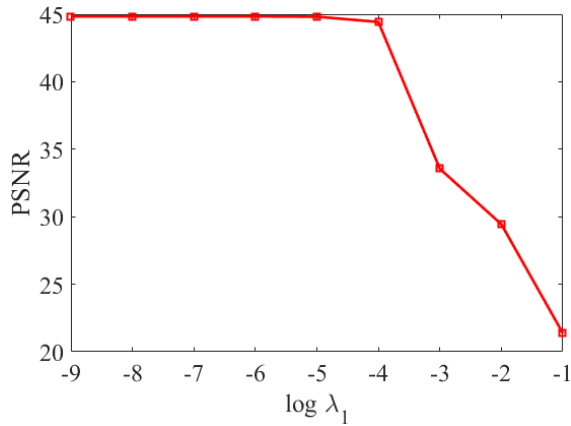
Figure 3. PSNR values for different log λ 1